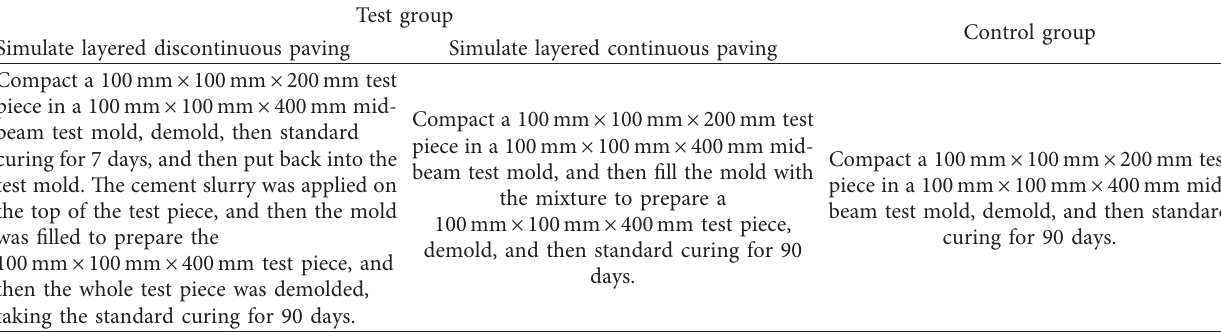
Table 1: Design of pulling strength test of core sample.